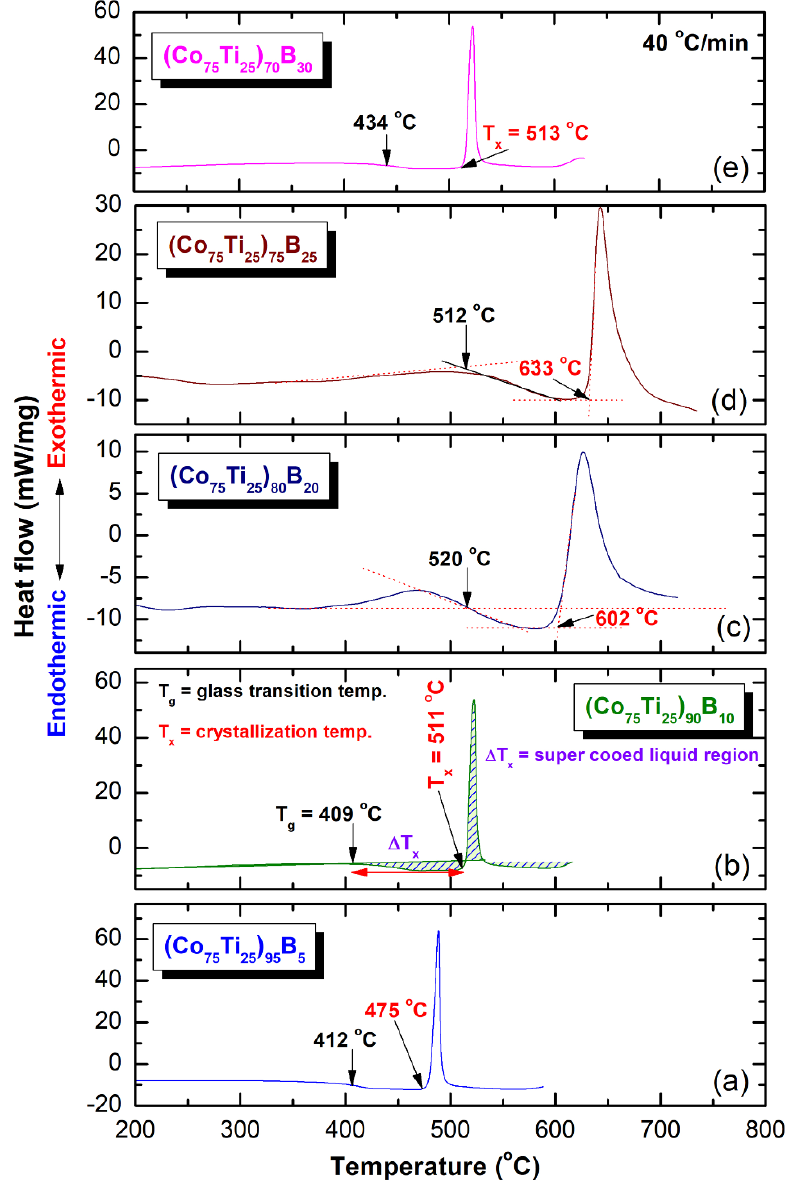
Figure 8. Di ff erential scanning calorimetry (DSC) thermograms of ( a ), (Co 75 Ti 25 ) 95 B 5 ( b ) (Co 75 Ti 25 ) 90 B 10 , The corresponding di ff erential thermal analysis (DTA) curves for these systems are presented in Figure 10.